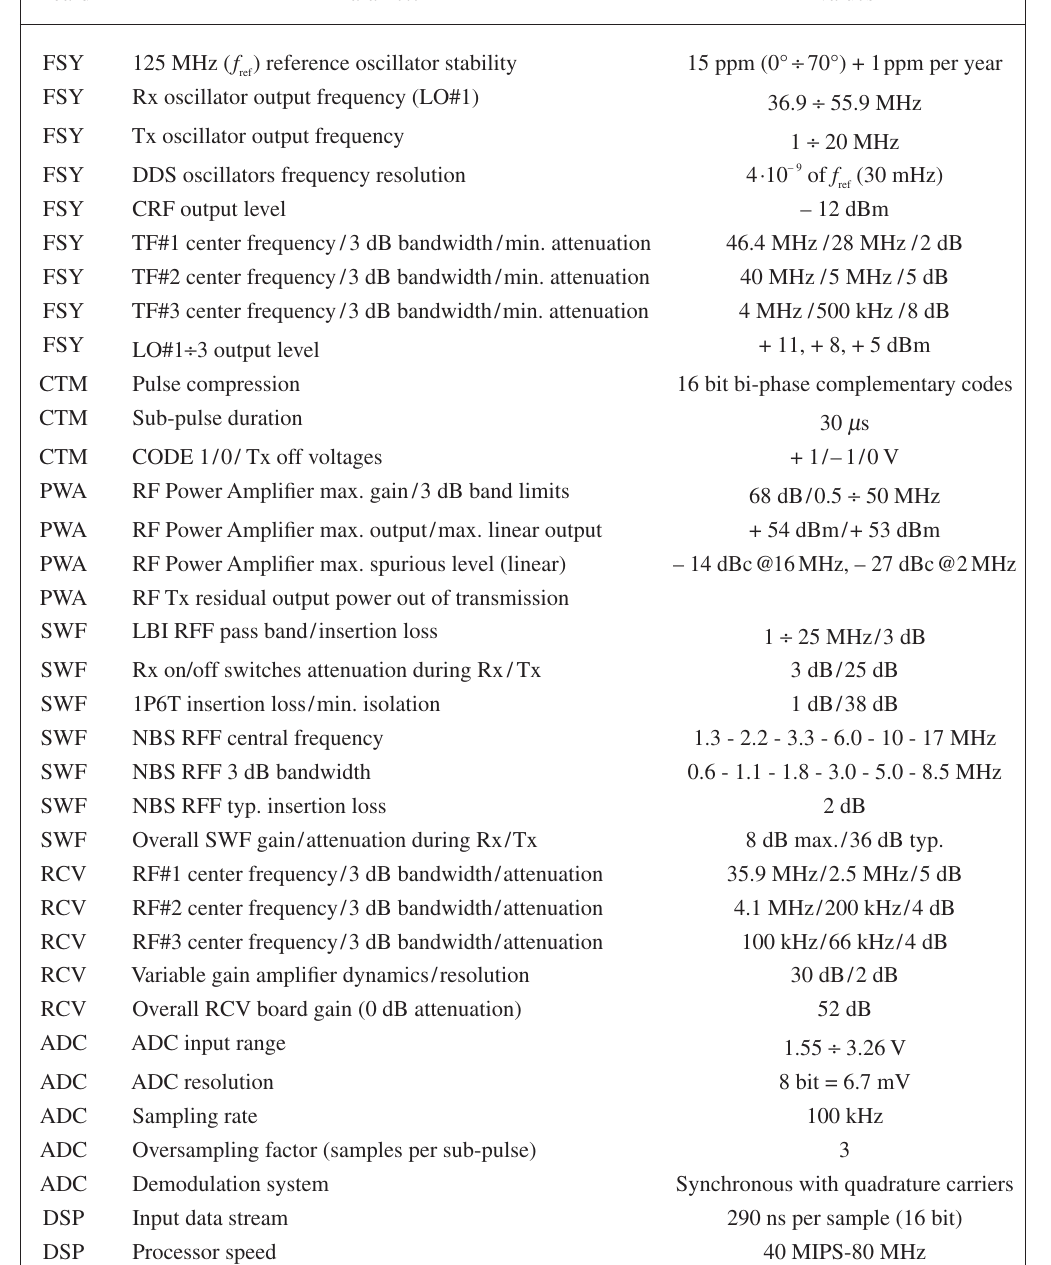
Table III. Functional blocks characteristics